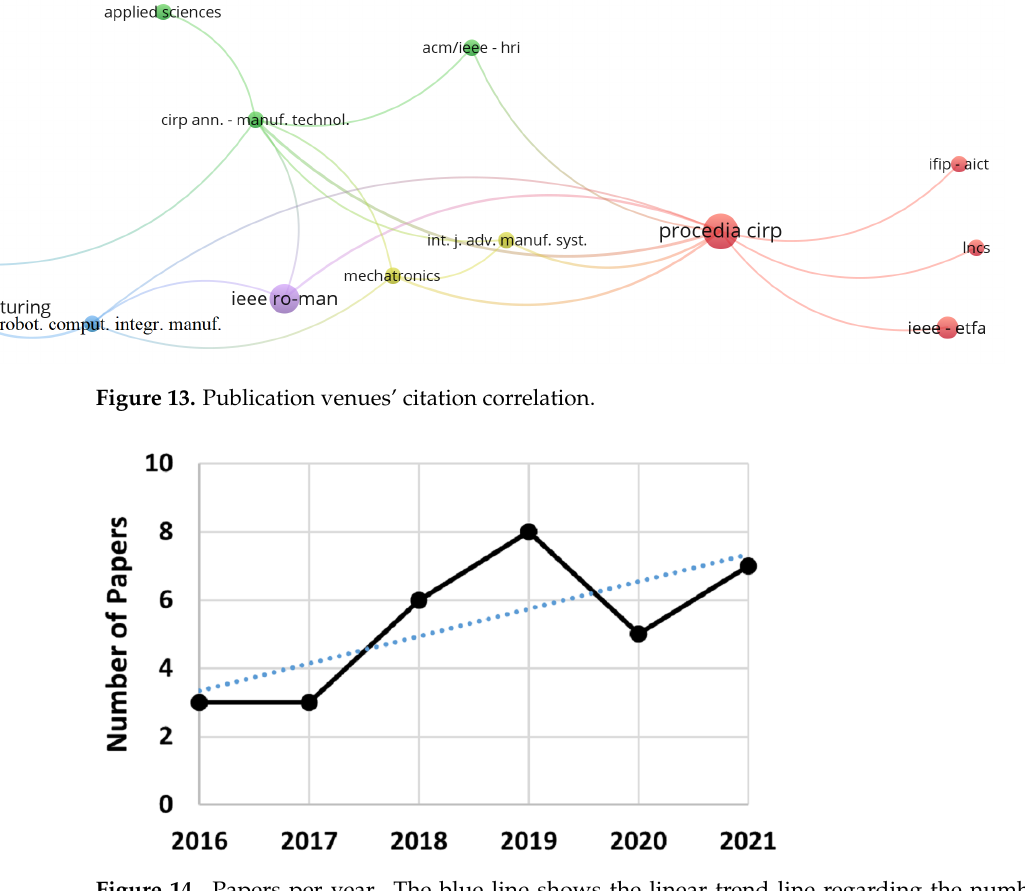
Figure 14. Papers per year. The blue line shows the linear trend line regarding the number of publications per year on AR for HRC